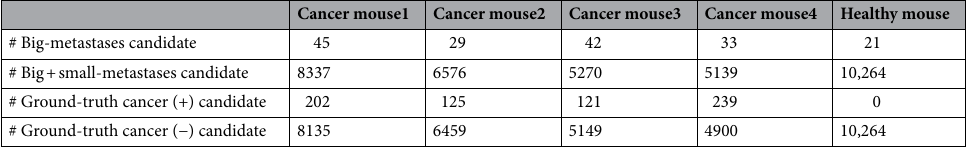
Table 1. The number of big-metastases candidates, big + small metastases candidates, ground-truth cancer (+), and ground-truth cancer (−) candidates in four cancer-bearing mice and one healthy mouse.